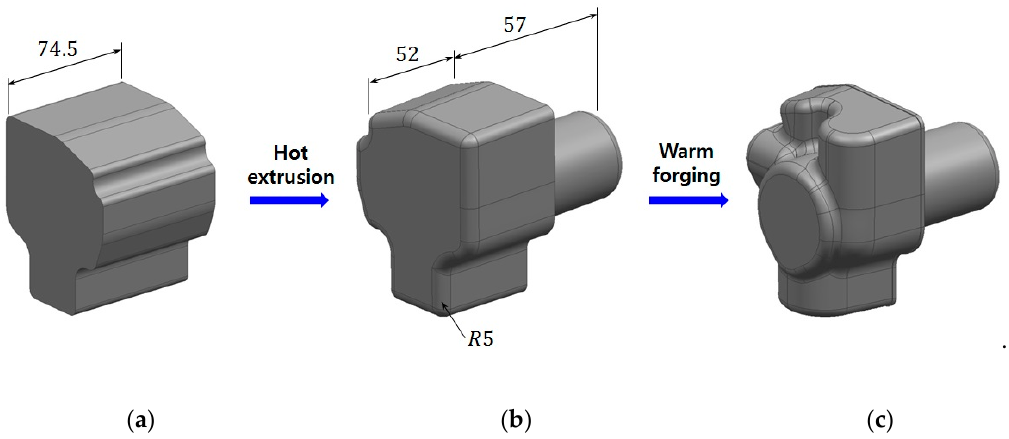
Figure 2. Forming process for fabricated umbrella-shaped part: ( a ) initial specimen; ( b ) blocker; ( c ) final part.